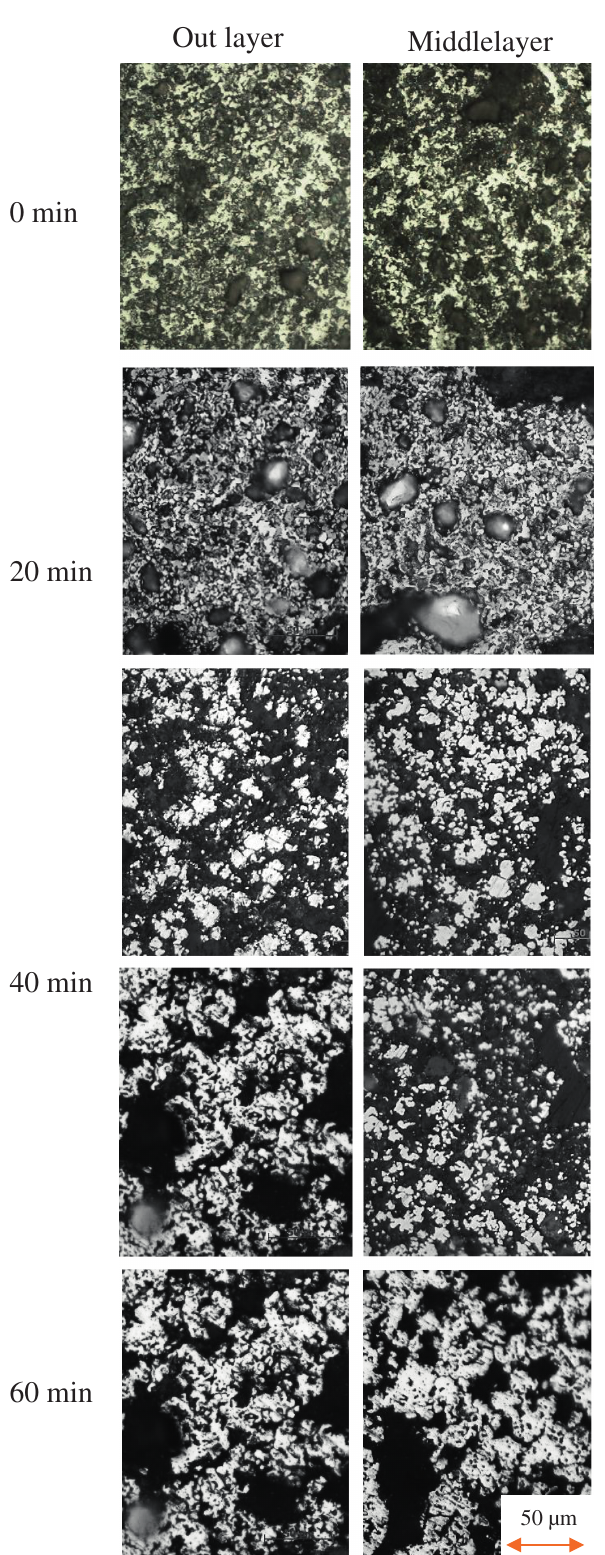
Figure 11: Microstructure of out layer and middle layer of reduced pellets (bright white, metallic